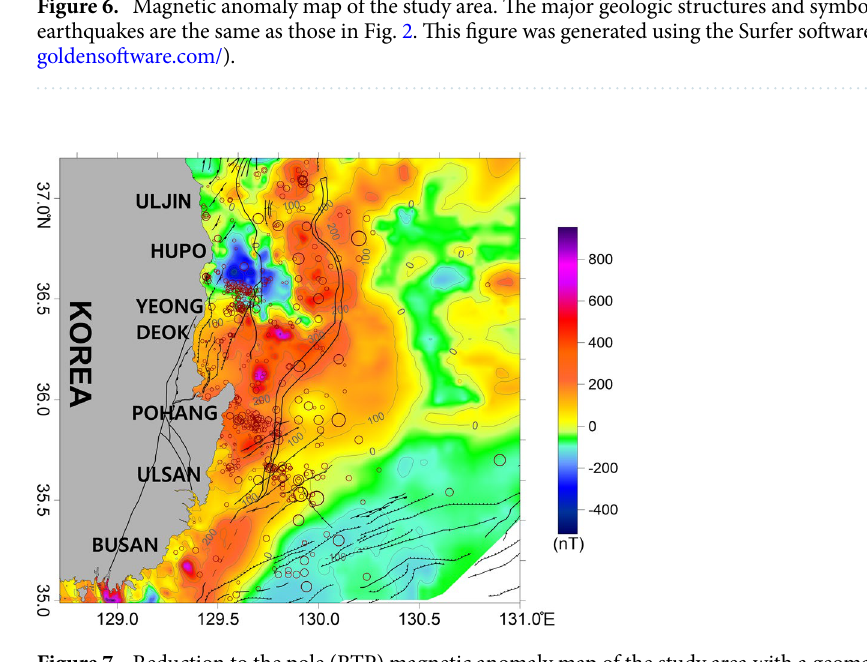
Figure 7. Reduction to the pole (RTP) magnetic anomaly map of the study area with a geomagnetic inclination of 52.3° and declination of −7.7°. The major geologic structures and symbols of the earthquakes are the same as those in Fig. 2. This figure was generated using the Surfer software (https:// www. golde nsoft ware.